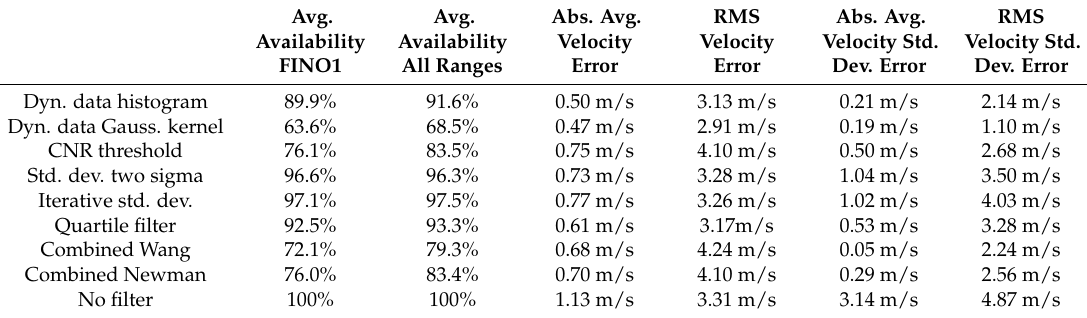
Table A1. Comparison of different filtering methods applied on staring mode measurements for wake affected wind directions from 110 ◦ to 180 ◦ .